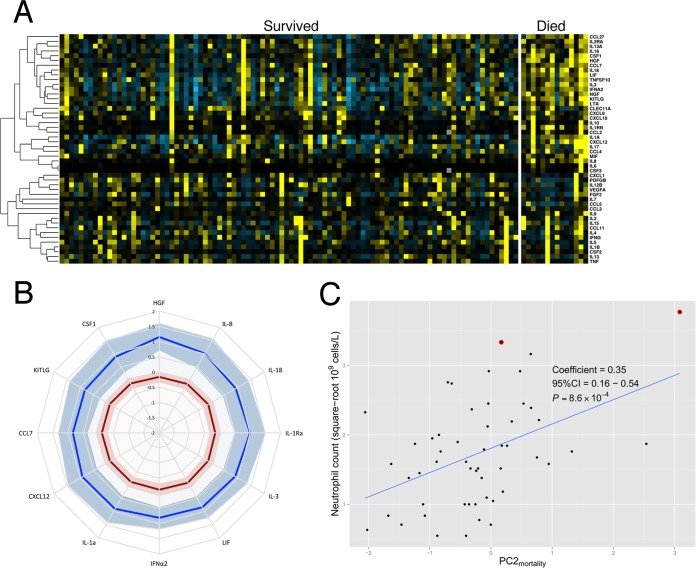
Serum cytokine responses to acute iNTS disease in African children with fatal and nonfatal disease. (A) Heat map of 48 serum cytokine concentrations during acute iNTS disease in children with nonfatal (left; n = 94) and fatal (right; n = 14) disease. Yellow color change represents increased cytokine concentration relative to the median for all samples, and blue color change represents a decrease. Cytokines are ordered by unsupervised hierarchical clustering, with between-cytokine distances represented by the dendrogram on the left side of the heat map. (B) Radar plot of the serum concentrations of cytokines (n = 12) in acute iNTS disease significantly differentiated between fatal (blue; n = 14) and nonfatal (red; n = 94) disease. Lower serum cytokine concentrations plot toward the center of the graph, and shaded areas represent 95% confidence intervals. Cytokine concentrations are normalized and standardized with rank-based inverse normal transformations. (C) Scatter plot of peripheral blood neutrophil counts and PC2mortality scores in Malawian children (n = 52) with acute iNTS disease. The linear regression line is plotted (blue). Two children with neutrophil count data subsequently died (data points highlighted with red circles).